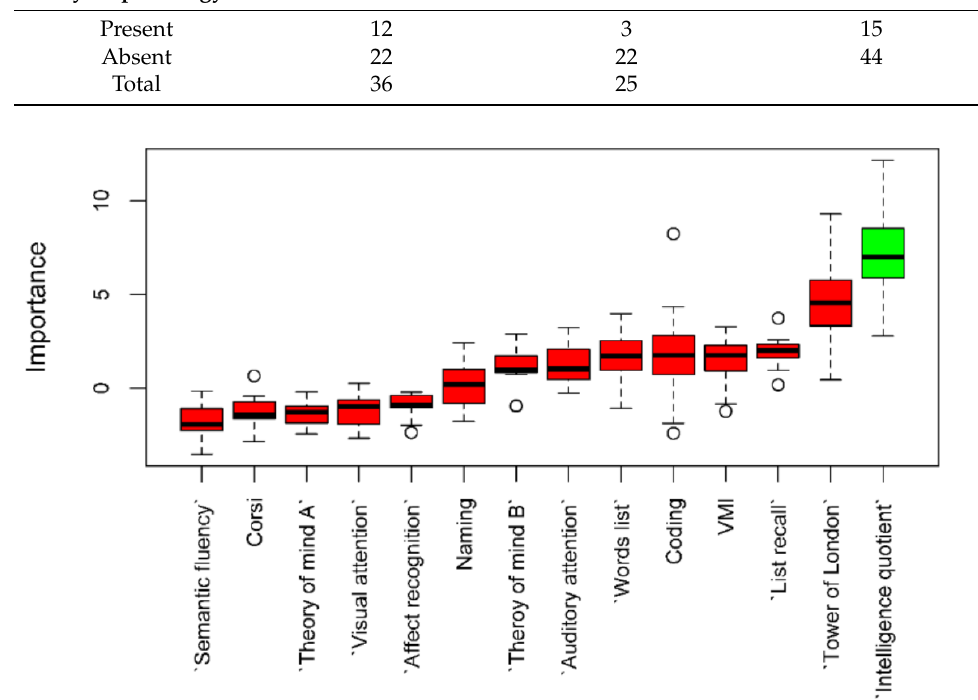
Figure 1. Boruta feature selection results. Green bar is IQ, the variable confirmed as important to distinguish the two groups of patients. Red bars represent the other variables included in the model but not confirmed as important. Dots in the upper or lower parts of the boxplots are outliers defined according to